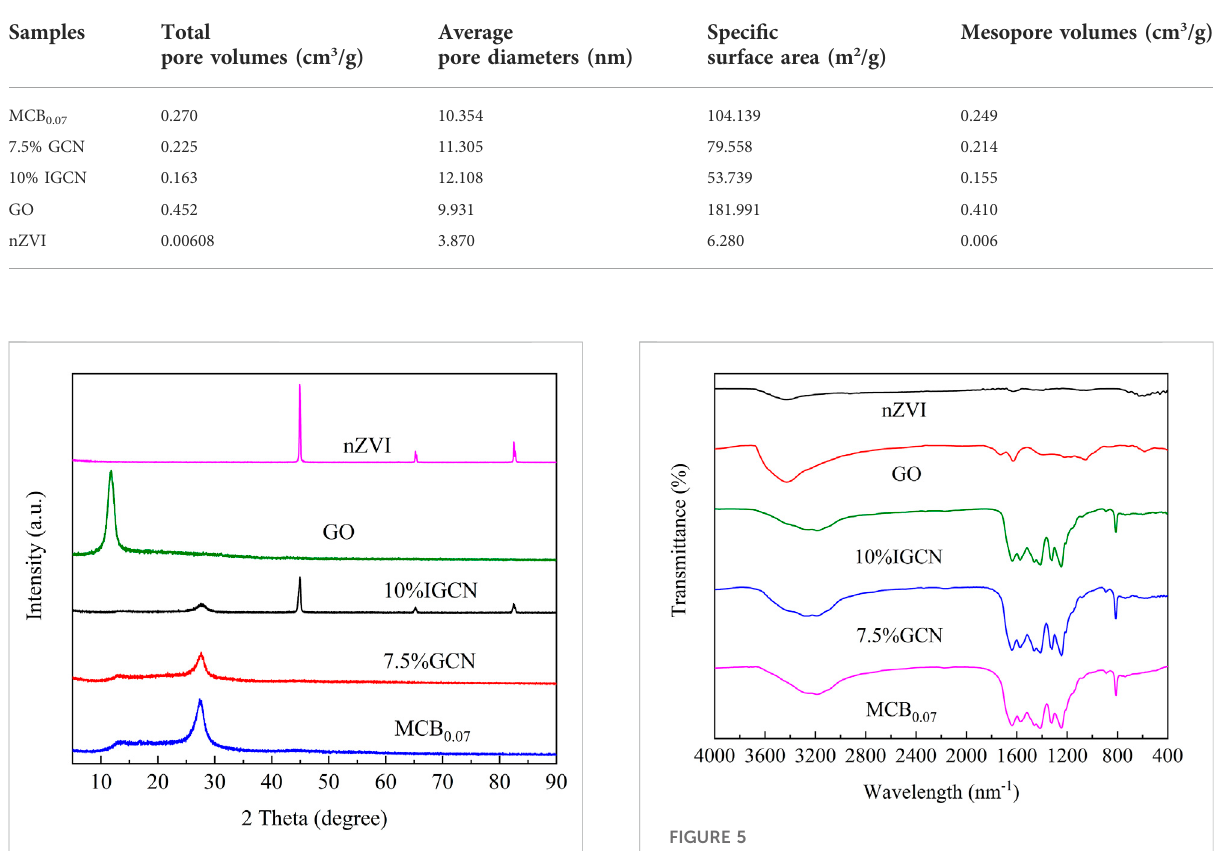
FIGURE 5 FTIR of as-prepared